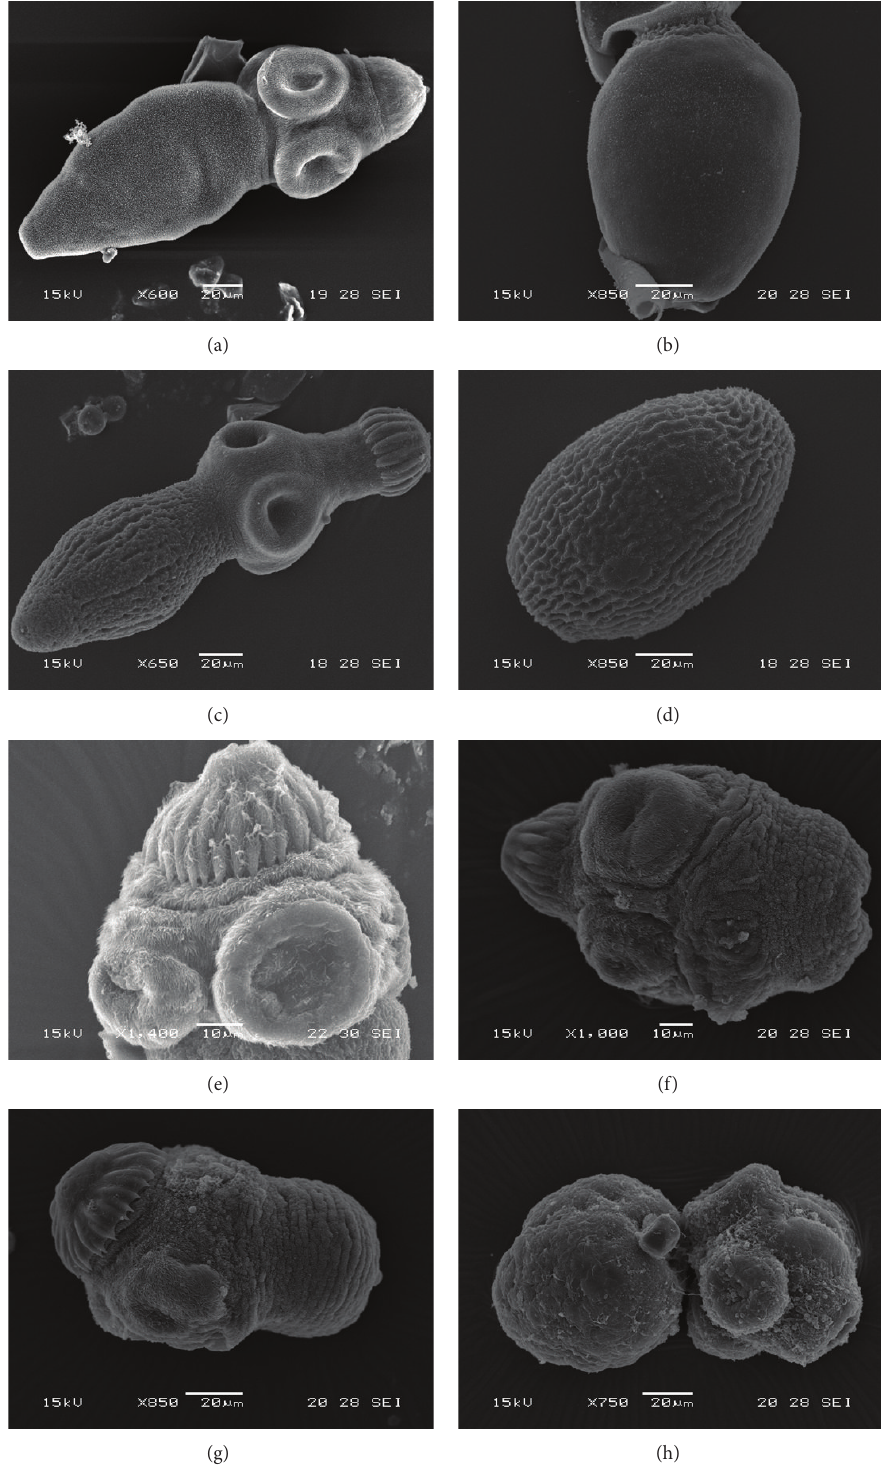
Figure 6: Scanning electron microscopy of E. granulosus protoscoleces incubated in vitro with thymol and essential oils of T. vulgaris and O. vulgare . (a) Evaginated control protoscolex (6 days p.i., 600x). (b) Invaginated control protoscolex (36 days p.i., 950x). (c) Altered protoscolex after 6 days p.i with T. vulgaris . Note the loss of microtriches at rostellar region (650x). (d) Invaginated altered protoscolex incubated with O. vulgare during 6 days (850x). (e) Scolex region of an evaginated protoscolex after 6 days with thymol. The shedding of microtriches can be observed (1400x). (f) Evaginated protoscolex ( T. vulgaris , 36 days p.i.). Note the shedding of microtriches at the scolex region, the presence of numerous blebs, and the contraction of the soma region (1000x). (g) Altered and contracted soma region ( O. vulgare , 36 days p.i.). Note the rostellar disorganization and shedding of microtriches (850x). (h) Completely altered protoscoleces (thymol, 24 days p.i.,